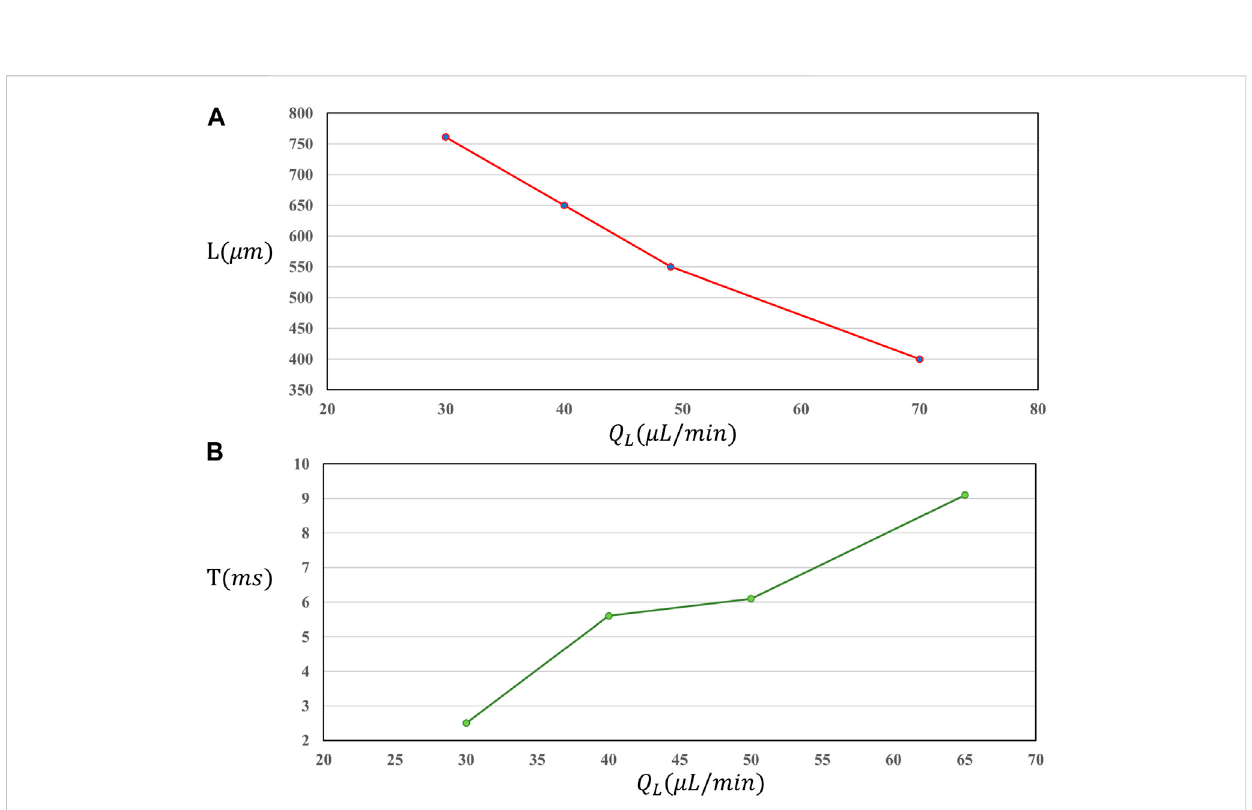
FIGURE 5 Characteristic length of slug under different liquid fl ow rate (A) ; Generation cycle under different liquid fl ow rate (B)